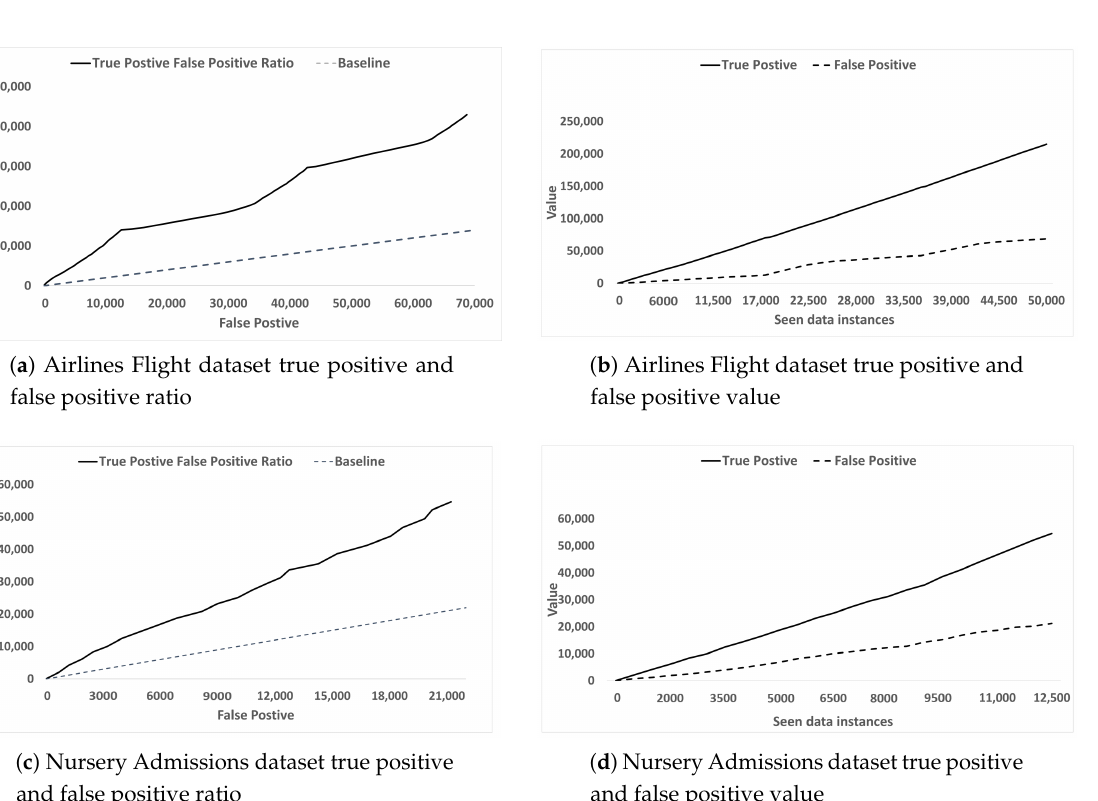
Figure 6. Relationships between ˆ P and ˆ N on the real datasets as the data streams in and FGRI